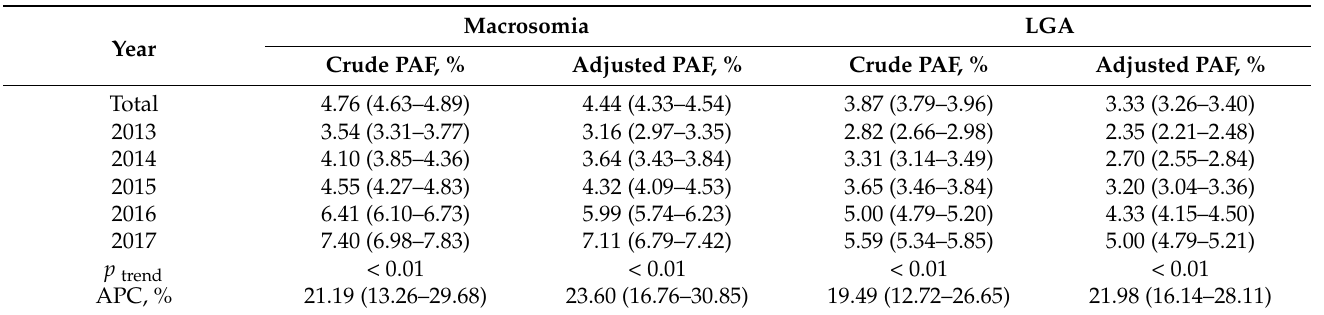
Table 3. Burden and Trends of Macrosomia and LGA Neonates Attributed to High Body Mass Index in China From 2013 to 2017.